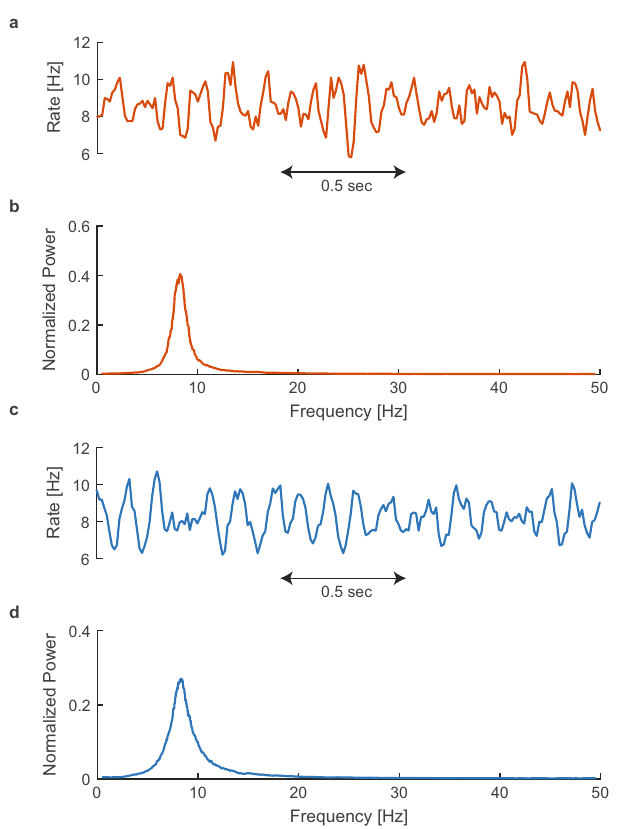
Figure 1. An example of the dynamics of a sparse excitatory neural network with neuronal response failures. ( a ) Simulation of Eqs (1–3), exemplified by the average firing over windows of d ( = 10 ms) . ( b ) The normalized smoothed power spectrum (convoluted with a rect(f/1 Hz) ) of 200 seconds of the time-dependent average firing rate. ( c – d ) Same as ( a – b ) but a numerical solution of Eqs (4–8), rather than a